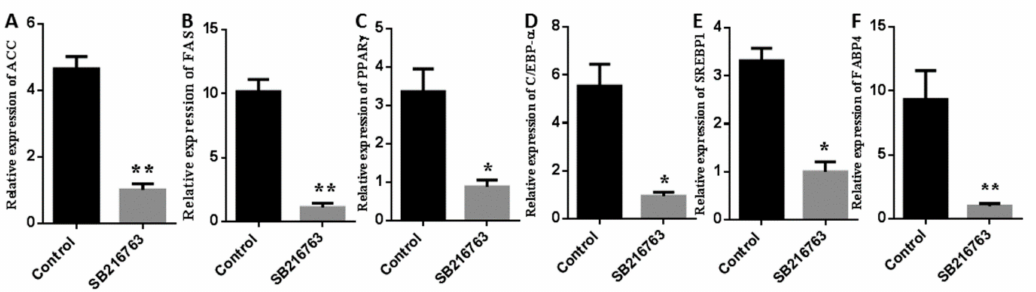
Figure 5. GSK3 β regulates the expression of lipogenesis-related genes in muscle satellite cells. Cells were incubated with SB216763 (10 µ M) for 7 days after adipogenic di ff erentiation. Expression levels of ACC ( A ), FAS ( B ), PPAR γ ( C ), C / EBP- α ( D ), SREBP1( E ), and FABP4 ( F ) was determined by qPCR. Error bars represent the SEMs of three separate experiments. ** p < 0.01; * p < 0.05 relative to control